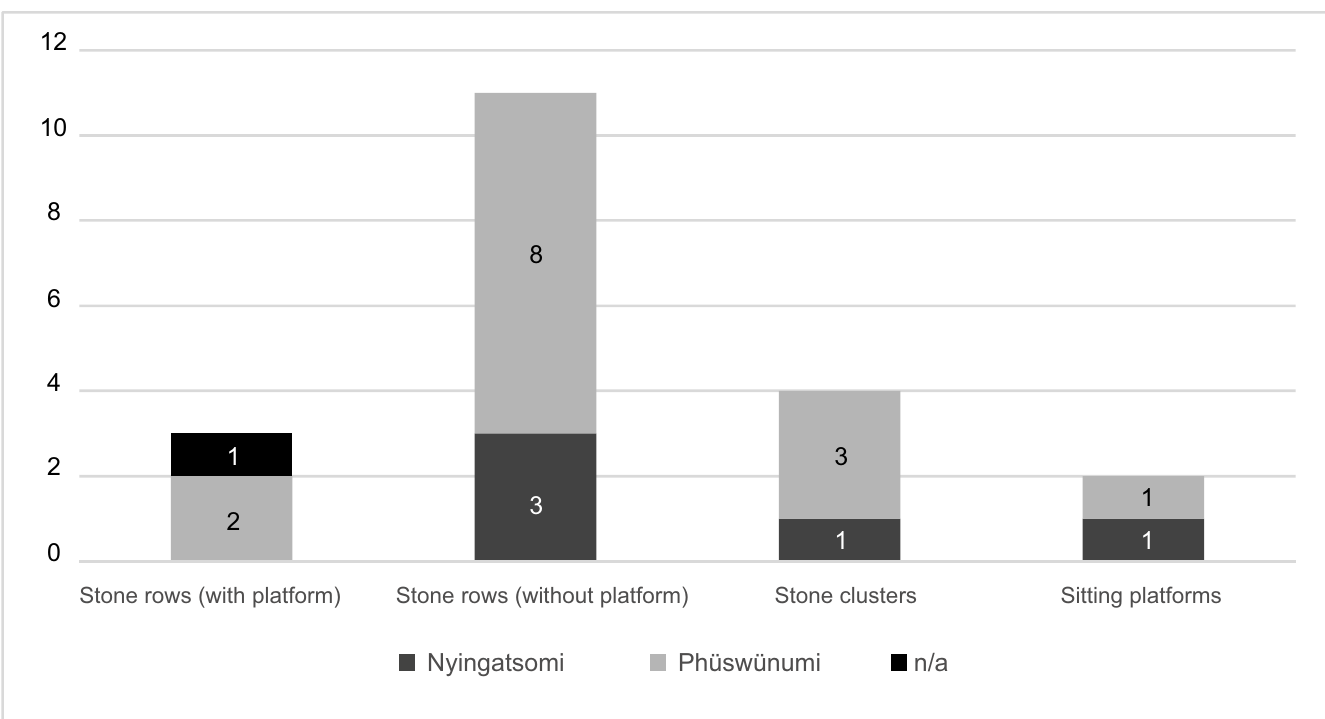
Fig 10. Diagram of the different monument types per khel in the Chakhesang Naga village of Ru¨nguzu (graphic: M. Wunderlich).